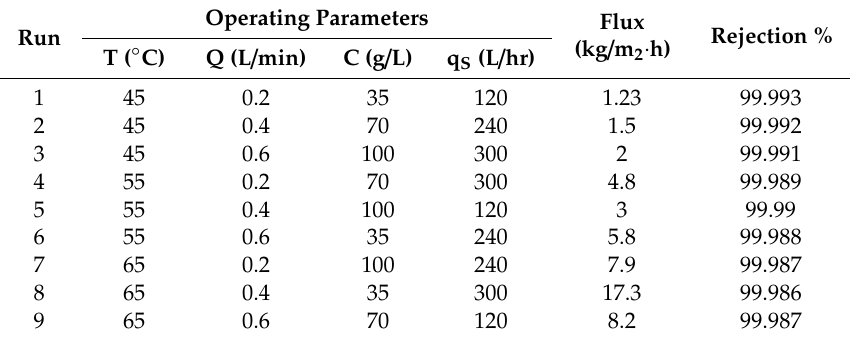
Table 4. Taguchi L 9 (3 4 ) OA, and result of experiments for commercial membrane.